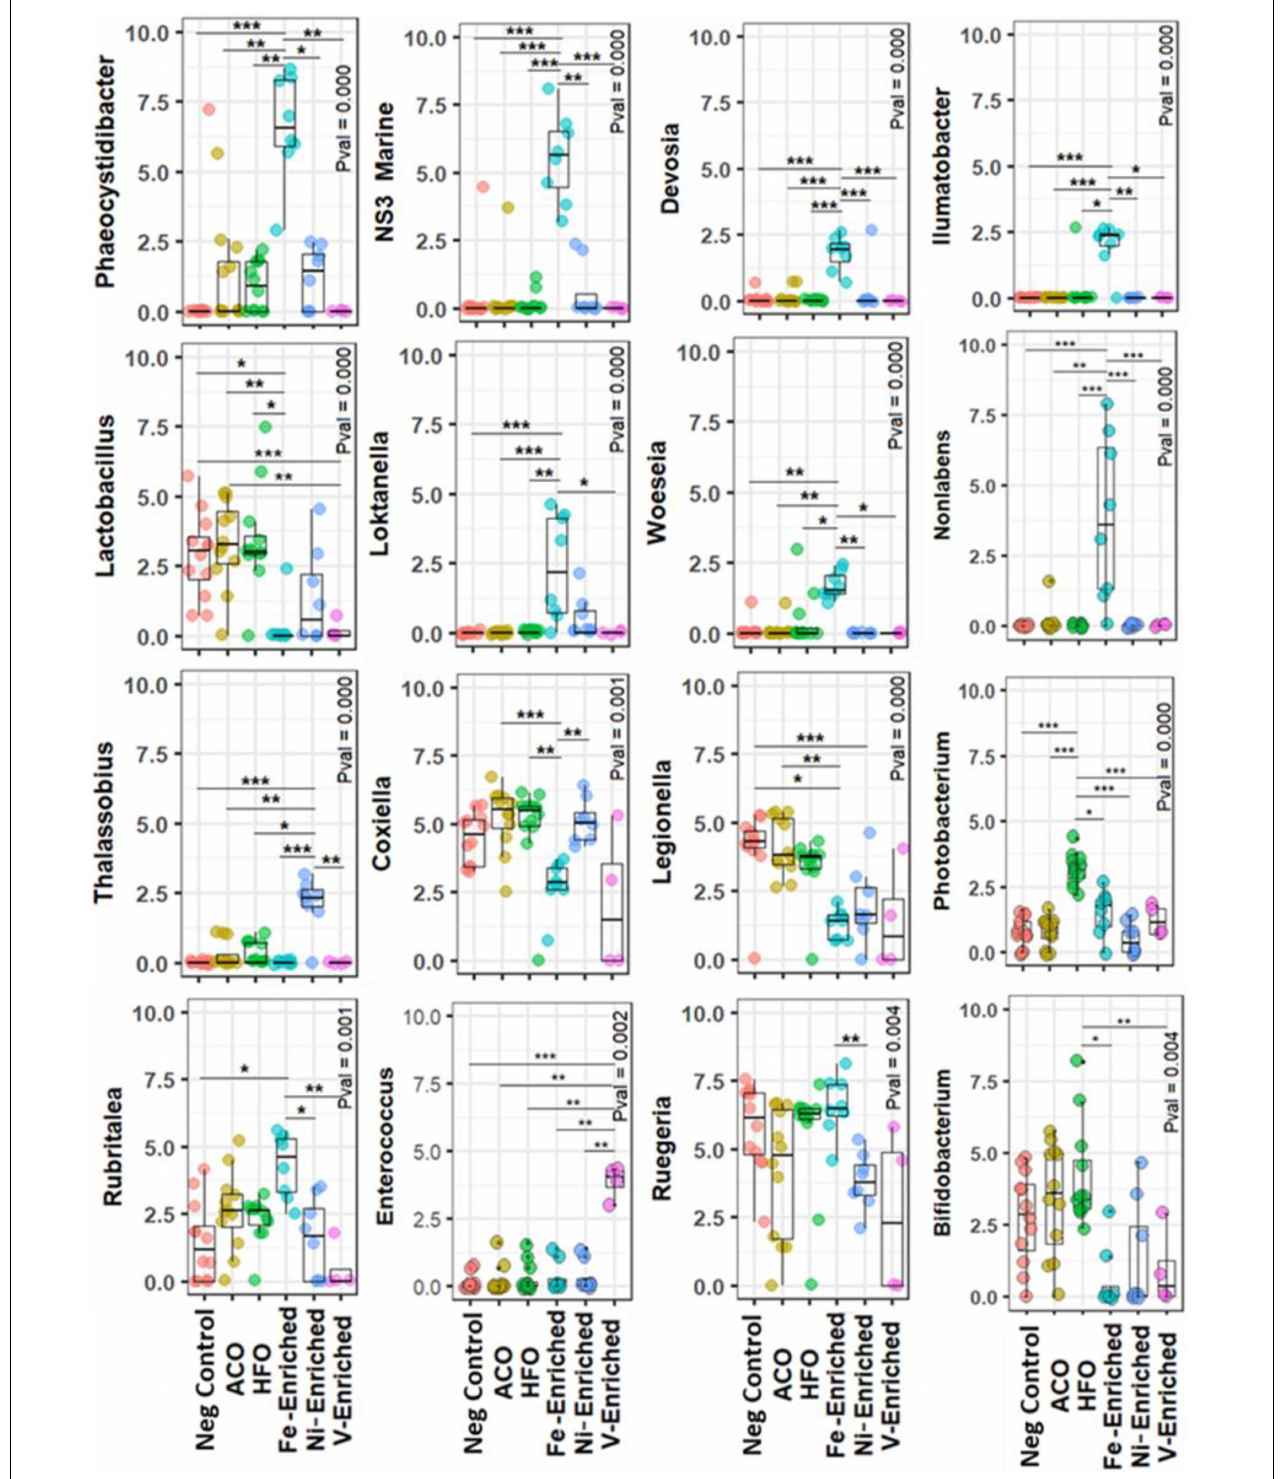
FIGURE 3 | Differential abundance of bacteria at the genus level in the gut of juvenile barramundi exposed to petroleum hydrocarbon and heavy metals. Rarefied abundances were log1p-transformed for generating plots Calculated using the Kruskal–Wallis along with the post hoc Dunn test. The P-value was adjusted with Bonferroni correction. *Significant at an α -level of 0.05. **Significant at an α -level of 0.005. ***Significant at an α -level of 0.001. Abbreviations: ACO, Australian crude oil; HFO, heavy fuel oil.